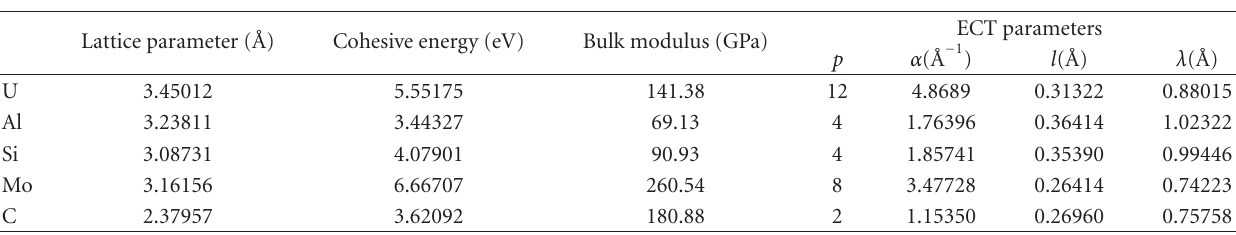
Table 1: LAPW results for the lattice parameter, cohesive energy, and bulk modulus for the bcc phases of U, Al, Si, Mo, and C, the resulting ECT parameters [27] p , α , l , and λ , and the BFS perturbative parameters Δ AB and Δ BA .